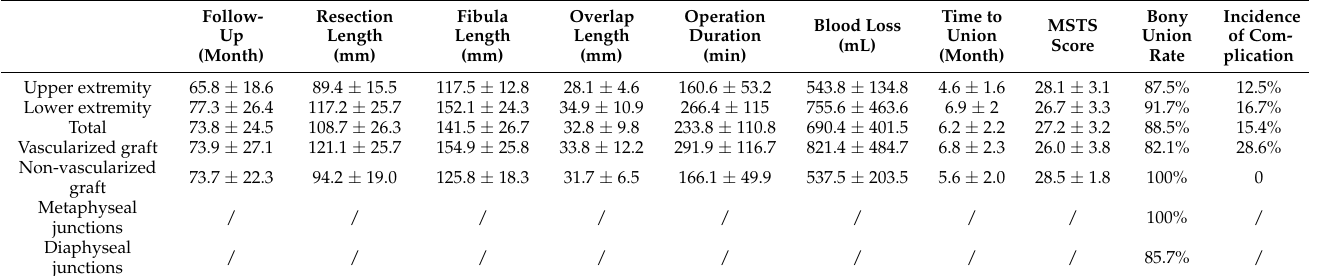
Table 3. Summary of Operative Details and Outcome.